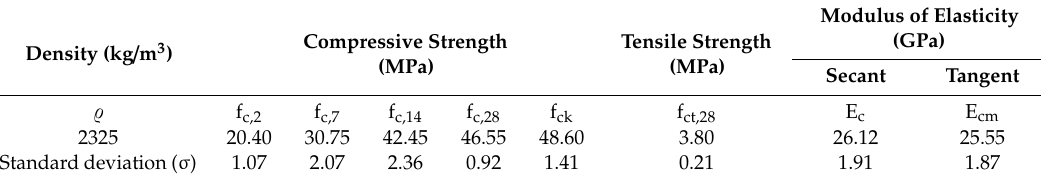
Table 4. The test results obtained on hardened concrete.